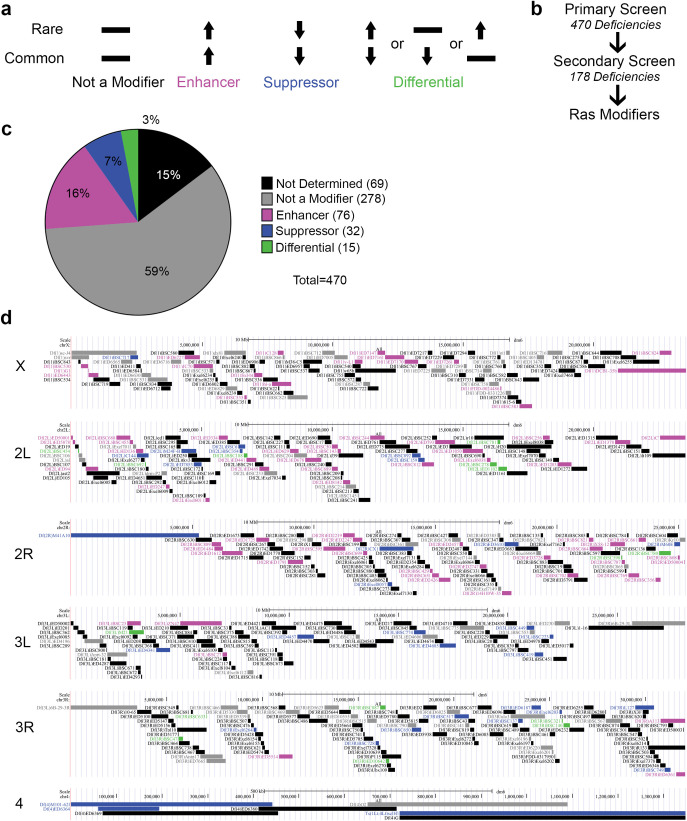
A genome-wide screen uncovers differential phenotypic regulation between strong and weak Ras/MAPK signaling states.(a) Schematic of the Ras modifiers types scored in the Df screen. (b) Schematic of screening approach. (c) Pie chart showing the number of Df with the indicated types of Ras modifiers. (d) Genome map of deficiencies color coded as in c for the class of Ras modifier.